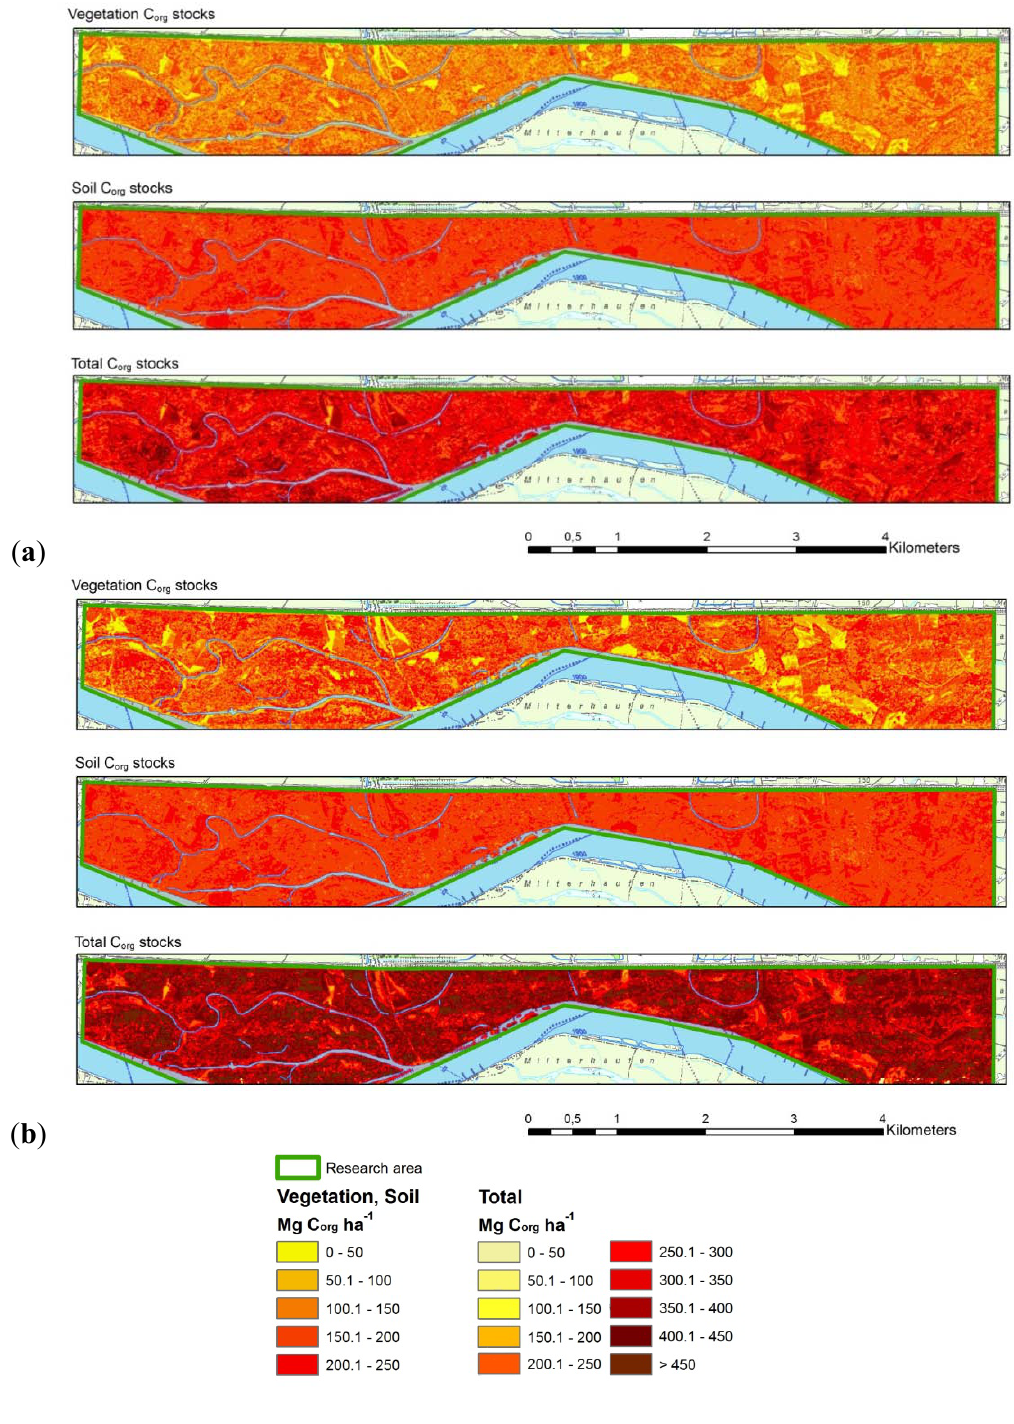
Figure 4. ( a ) C stocks in vegetation (above), soil (middle) and total (below), calculated org by kNN method based on RapidEye; ( b ) Corg stocks in vegetation (above), soil (middle) and total (below), calculated by kNN method based on RapidEye and additional